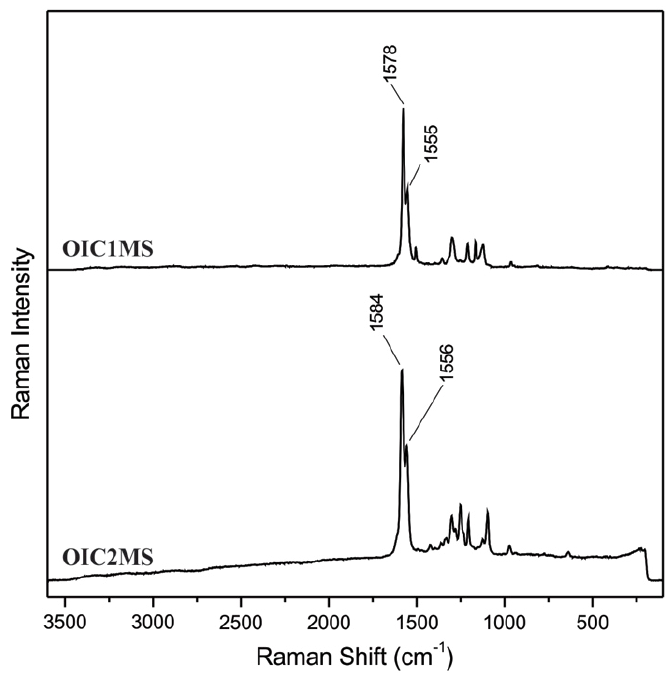
Figure 2. Raman spectra of